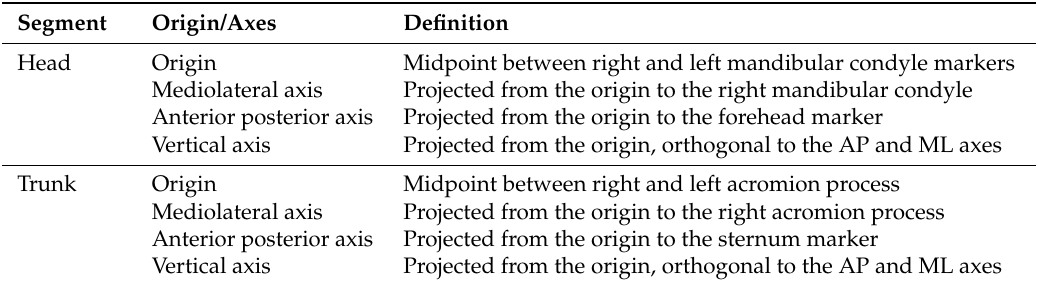
Table 2. Head and trunk segment